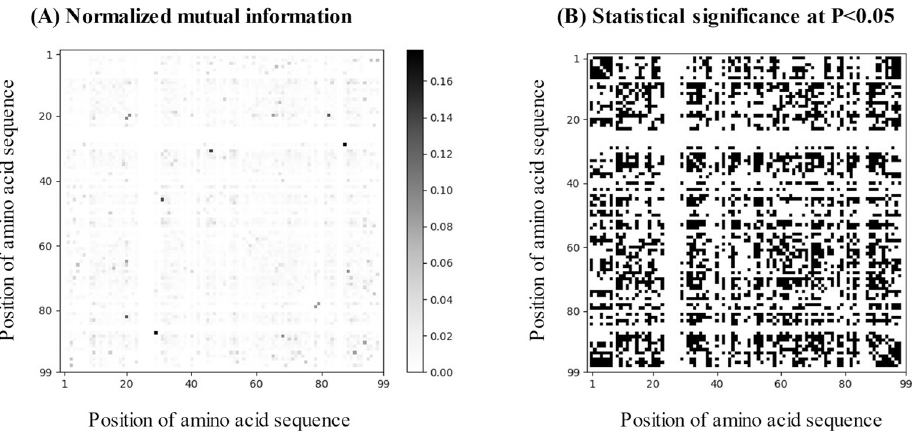
Fig 2. Normalized mutual information on co-occurrence of amino acids between any two positions. (A) Gray-scale image matrix of normalized mutual information (NMI). (b) Statistical significance of NMI determined by permutation test at P < 0.05